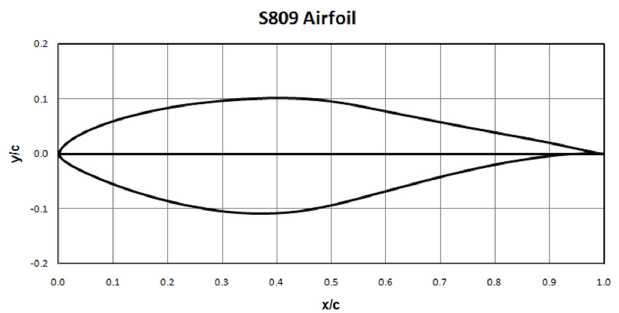
Figure 1. The NREL S809 airfoil coordinates and graphic [43].